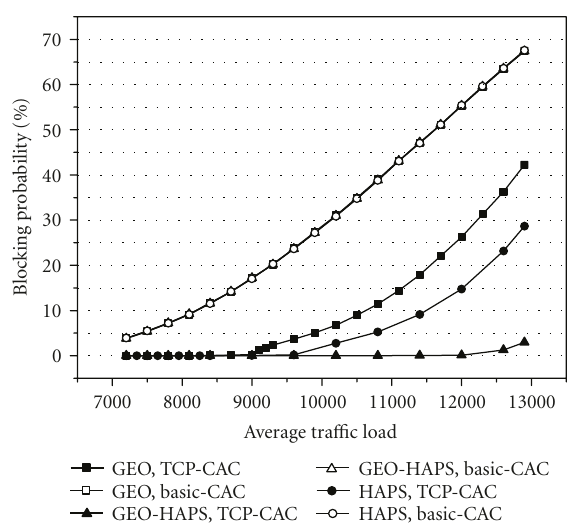
Figure 6: Blocking probability versus average tra ffi c